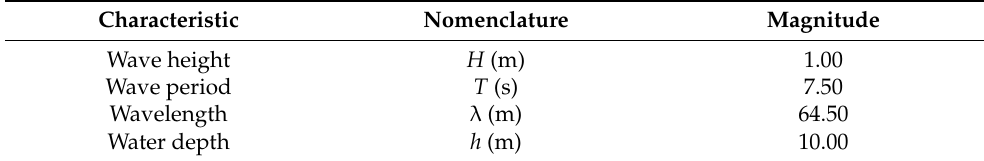
Table 1. Characteristics of the regular